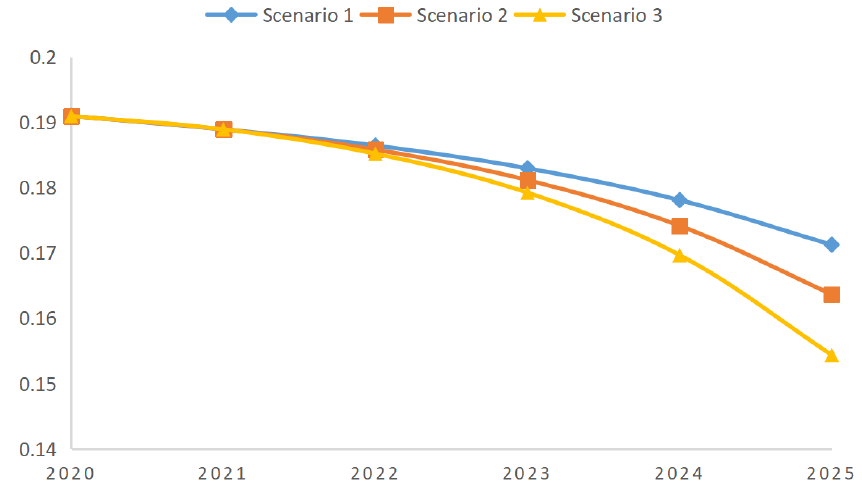
Figure 8. Integrated carbon emission reduction factors.